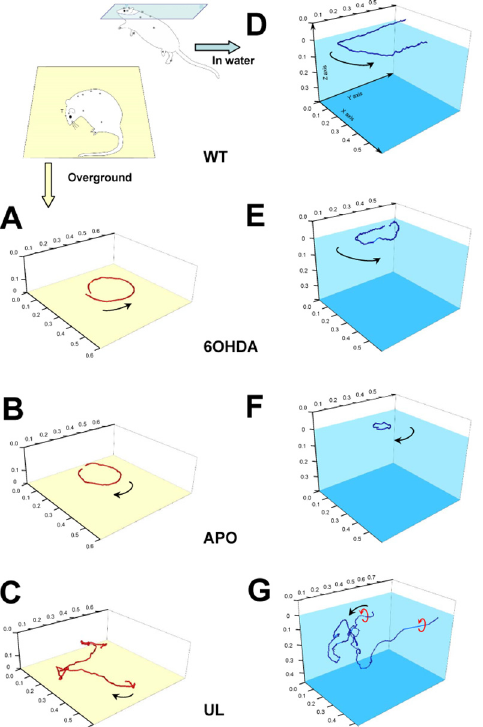
Fig 3. 3D head trajectory showing circling and pivoting behaviors overground or in the water. The position and trajectory of the head recorded in the 3 dimensions of space by a multi- camera system during 11 seconds (200 Hz) overground (A, B, C) or in the water ( D, E, F, G) . (A) Example trajectory of rat with unilateral degeneration of the whole nigro-neostriatal dopamine (DA) neuron system by intracerebral injection of 6-hydroxy-DA (6-OHDA) overground; The 6-OHDA rats with a lesion on the left side present only anti- clockwise (ipsiversive to the lesion) circling behavior on the ground. The head trajectory is in the horizontal plane, since the control of the head position is supplied by proprioceptive afferents (limbs, vibrisses). (B) Example trajectory of APO rats over ground; a systemic injection of apomorphine (APO) to a 6-OHDA rat results in pivoting behavior toward the opposite side of the lesion (controversive to the lesion). This is due to the activation of the supersensitive DA receptors, which are deprived of their DA afferences. As in 6-OHDA, the trajectory of the head is also in the horizontal plane. (C) Example of trajectory of left hemi-lateral labyrintectomy rats (UL) over ground; the UL rats explore the environment in a clockwise direction (contraversive to the lesion) with their heads inclined slightly on the lesion side. The trajectory of the head is in horizontal and vertical planes. (D) Example of swimming of the control rat (WT). It explored the environment following the edge of the pool. (E) Example trajectory of 6-OHDA in the water; the respiratory constraint causes the rat to swim with the snout in a more upward position compared to the ground. The sense of rotation and the diameter of the circle are the same as in over ground. The trajectory of the head is slightly in the horizontal plane (F) Example trajectory of APO rats in water. As in over ground, the systemic injection of apomorphine (APO) results in pivoting behavior toward the opposite side of the lesion. The diameter of the trajectory is tighter than 6-OHDA in the water or APO over ground. As in 6-OHDA, the trajectory of the head is in the horizontal plane. (G) Example trajectory of hemi-lateral labyrintectomy rats (UL) in water; the anti- clockwise rolling movements (red arrows) were immediately triggered when the individual attempted to swim. The head position varies highly among the three directions of space. Scale units are in meters. Arrows indicate the direction of the